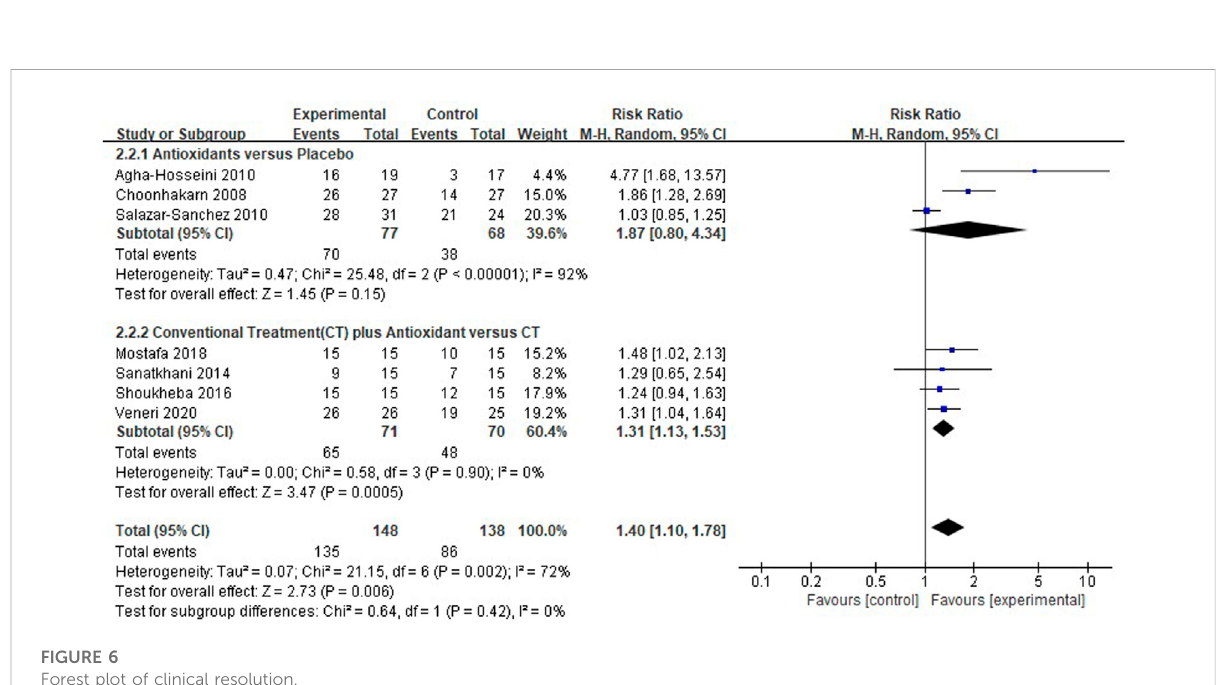
FIGURE 5 Forest plot of pain resolution.